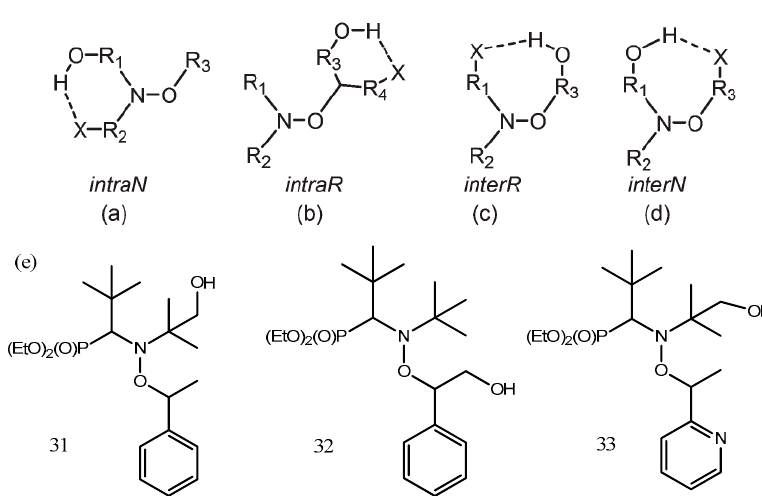
Figure 18. Various types of intramolecular hydrogen bonds (IHBs): ( a ) within the nitroxyl moiety ( intraN ); ( b ) within the alkyl part ( intraR ); ( c ) from an alkyl to nitroxyl part ( interR ); and ( d ) from a nitroxyl to alkyl part ( interN ). Dotted lines represent an IHB. ( e ) Structures of alkoxyamines 31 – 33 .